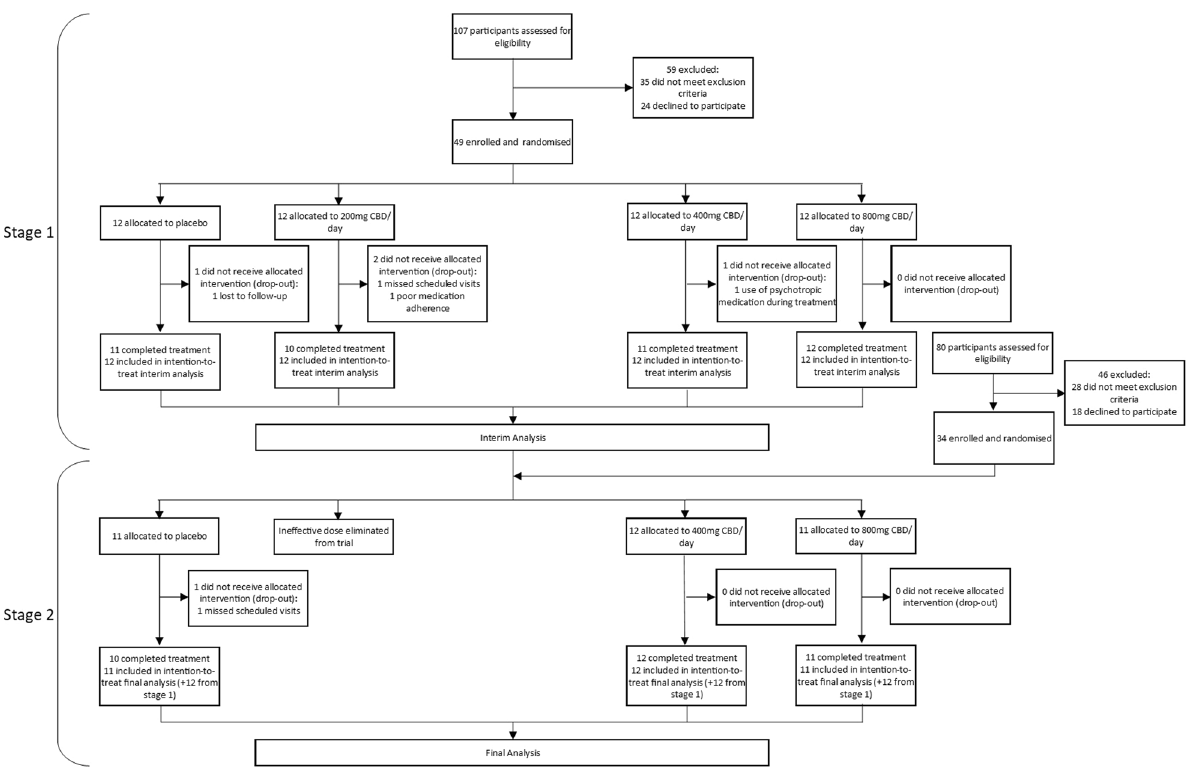
Fig. 1 CONSORT diagram. Diagram showing enrolment, allocation, and the groups at each stage of